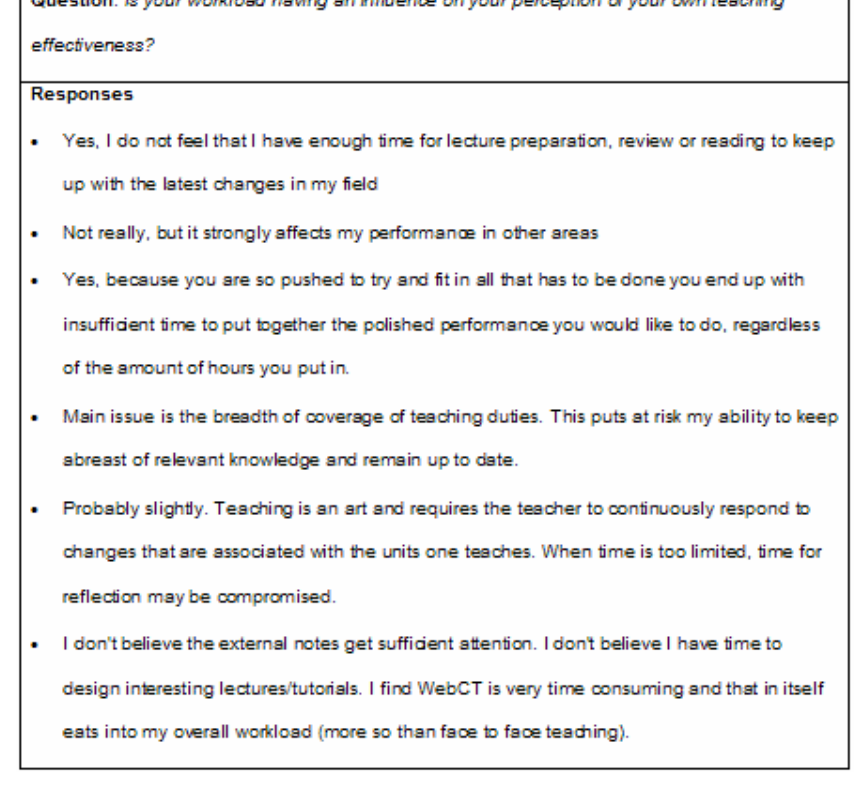
Table 1. Perceptions of impact of academic workload on individual teaching effectiveness, Faculty of Rural Management, University of Sydney, 2002.